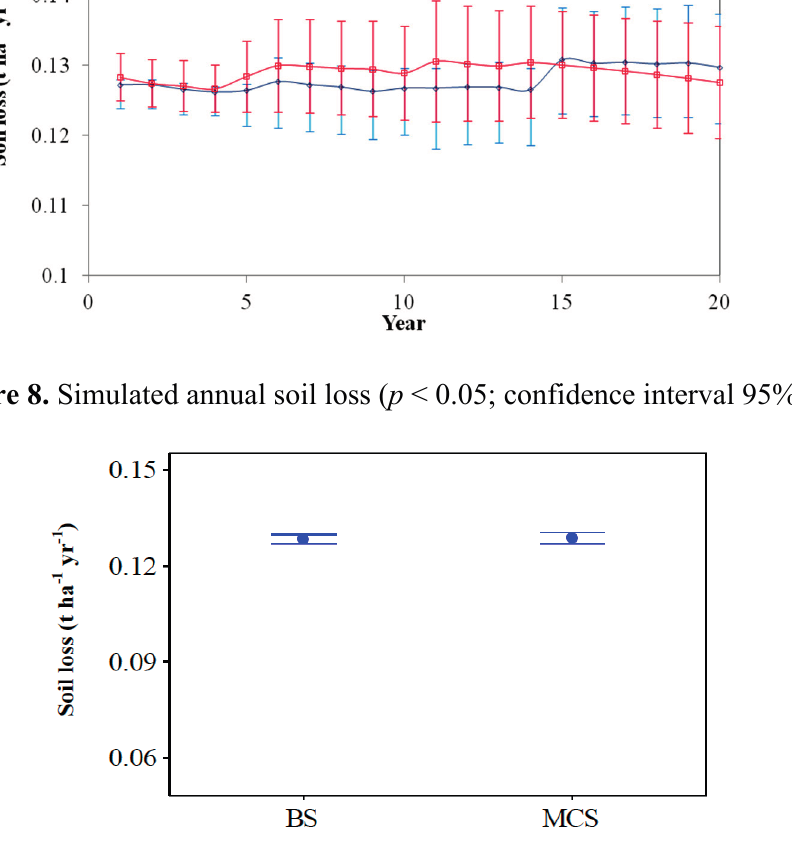
Figure 9. Average annual soil loss ( p < 0.05; confidence interval